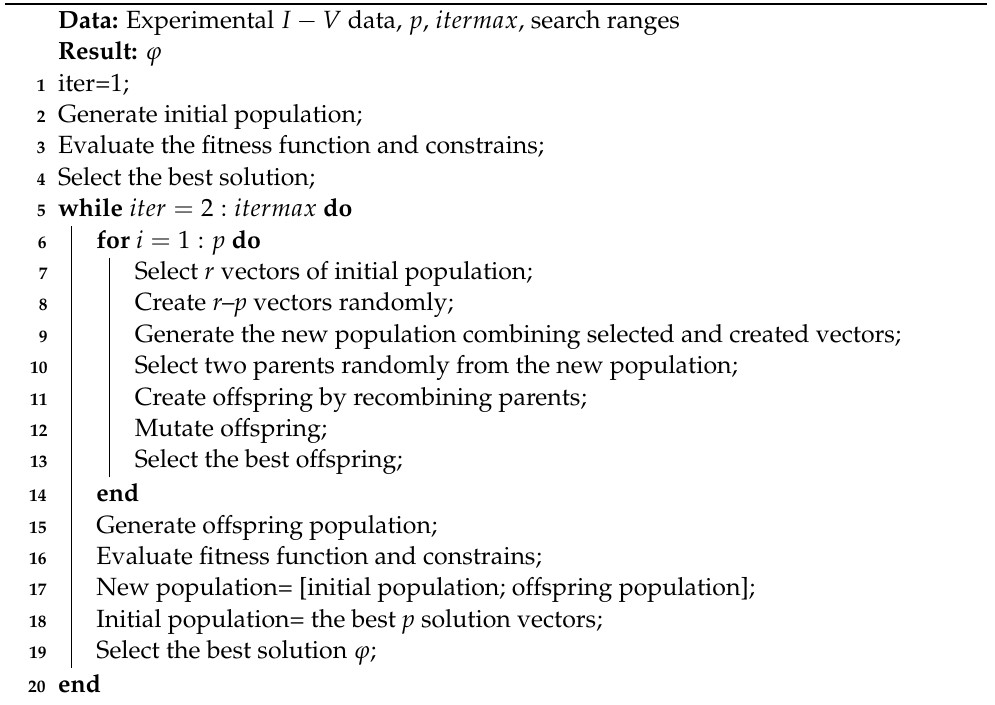
Algorithm 1: Pseudocode of GA applied to PV cell parameter estimation. Data: Experimental I − V data, p , itermax , search